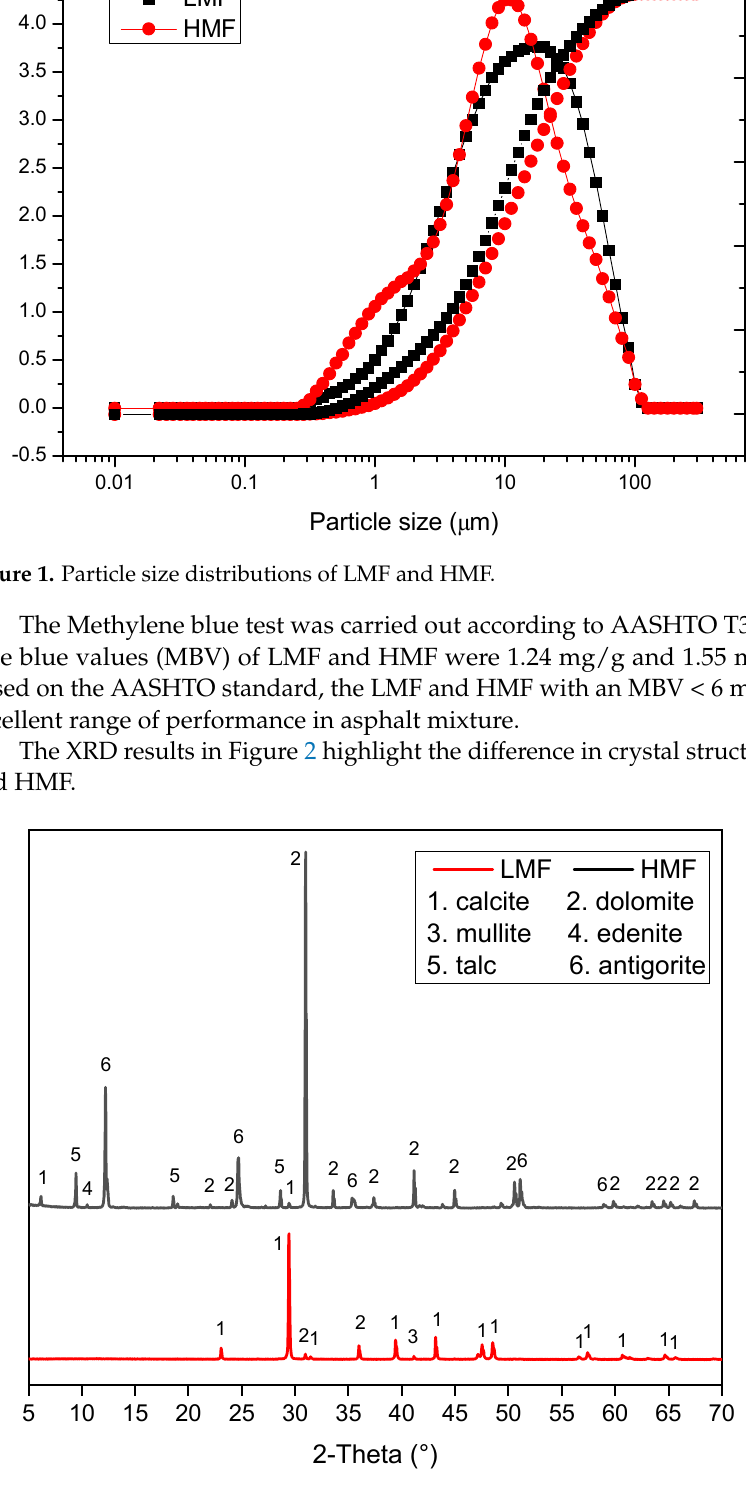
Figure 2. XRD results of LMF and HMF.